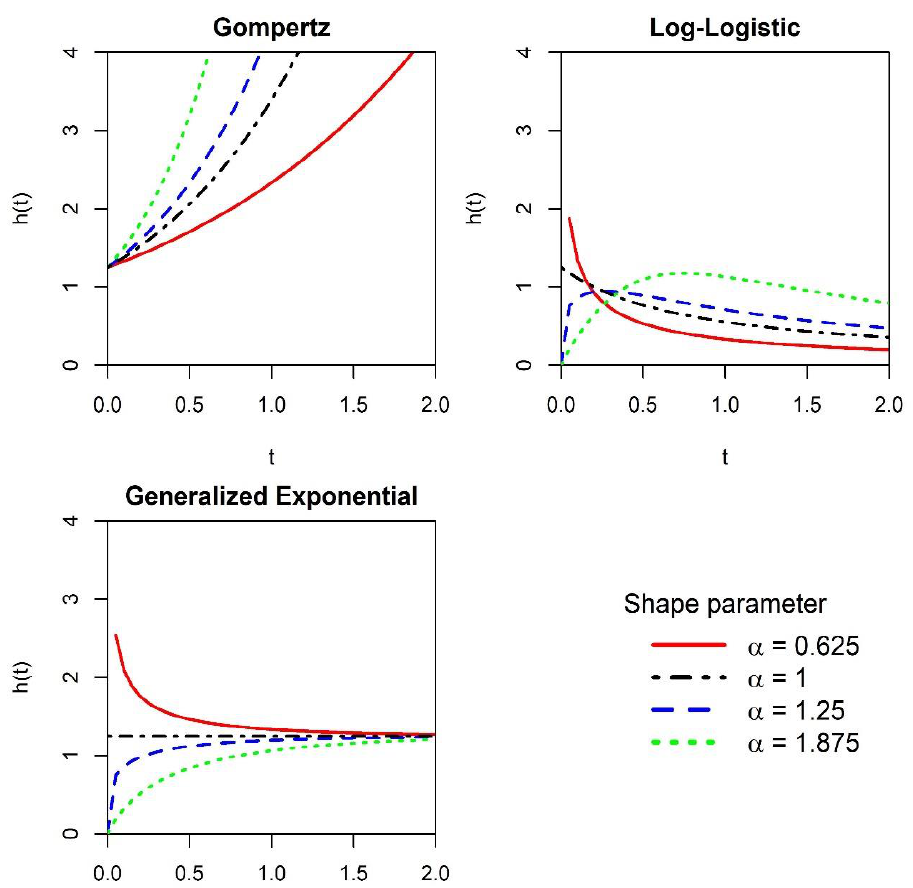
Figure 1. Hazard function plots for Gompertz, log-logistic, and generalized exponential distribution for ω = 1.25 and varying shape parameter